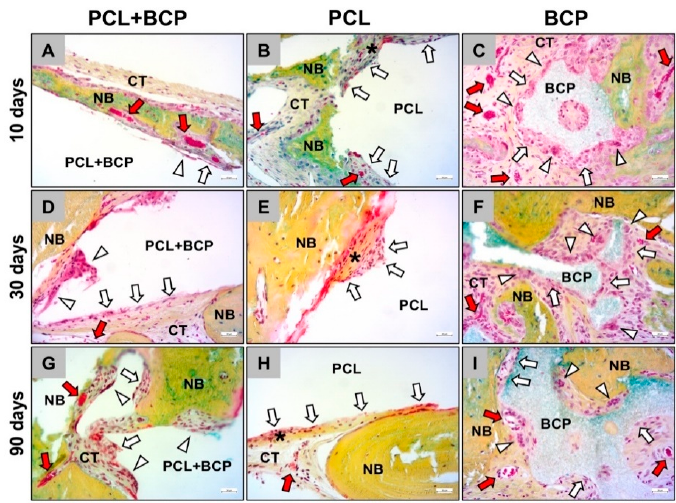
Figure 9. Exemplary histological images that show the tissue reactions to the three biomaterials through the course of the study. Tissue reactions at ( A – C ) day 10 post implantationem, ( D – F ) day 30 post implantationem and ( G – I ) day 90 post implantationem. White arrows = mononuclear cells, white arrowheads = multinucleated giant cells, red arrows = blood vessels, black asterisks = fibrosis- like tissue, NB = newly formed bone, CT = connective tissue (Movat Pentachrome stainings, 20× magnifications, scalebars = 20 µm).